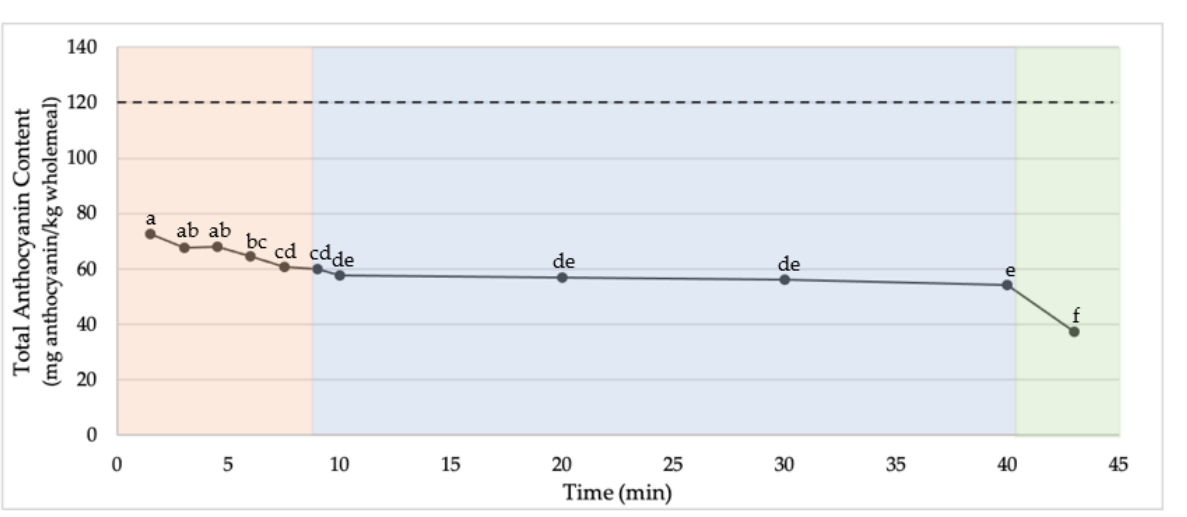
Figure 1. Total anthocyanin content (in mg anthocyanin/kg wholemeal) of AnthoGrain™ cracker dough, and crackers throughout the cracker production process (mixing = red, resting/shaping = blue, and baking = green). The dashed line indicates the starting anthocyanin content of the wholemeal used (samples with different letters are significantly different at α = 0.05). Table 2. Loss of total anthocyanin content (expressed as %) at each cracker processing step.